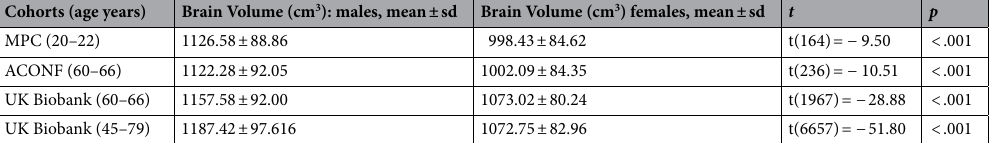
Table 2. Differences in brain volume between sexes for all data sets: the Indian sample (Mysore Parthenon Cohort, MPC), Scottish (Aberdeen Children of the 1950s, ACONF) and UK